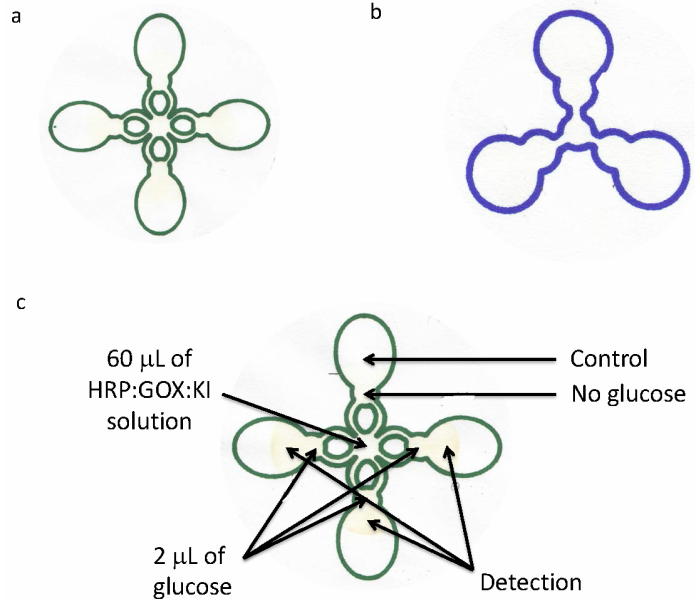
Figure 1. ( a ) Cloverleaf (four-channel) and ( b ) shamrock (three-channel) μPADs used in this study; ( c ) Representation of samples spotted on cloverleaf μPAD.